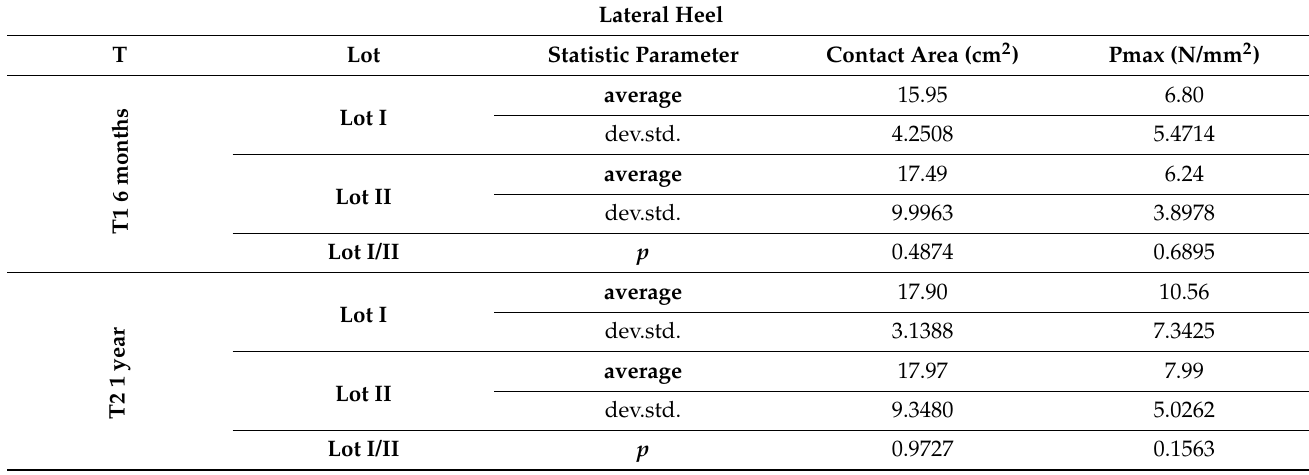
Table 3. Average values for lateral heel, 6 months and 1 year.